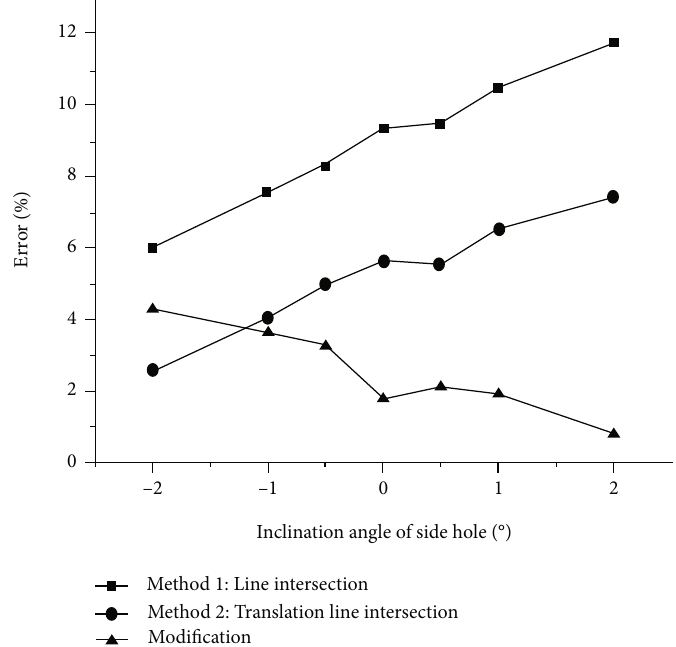
Figure 11: Comparison of the error-side hole inclination for di ff erent methods of predicting pile bottom depth.